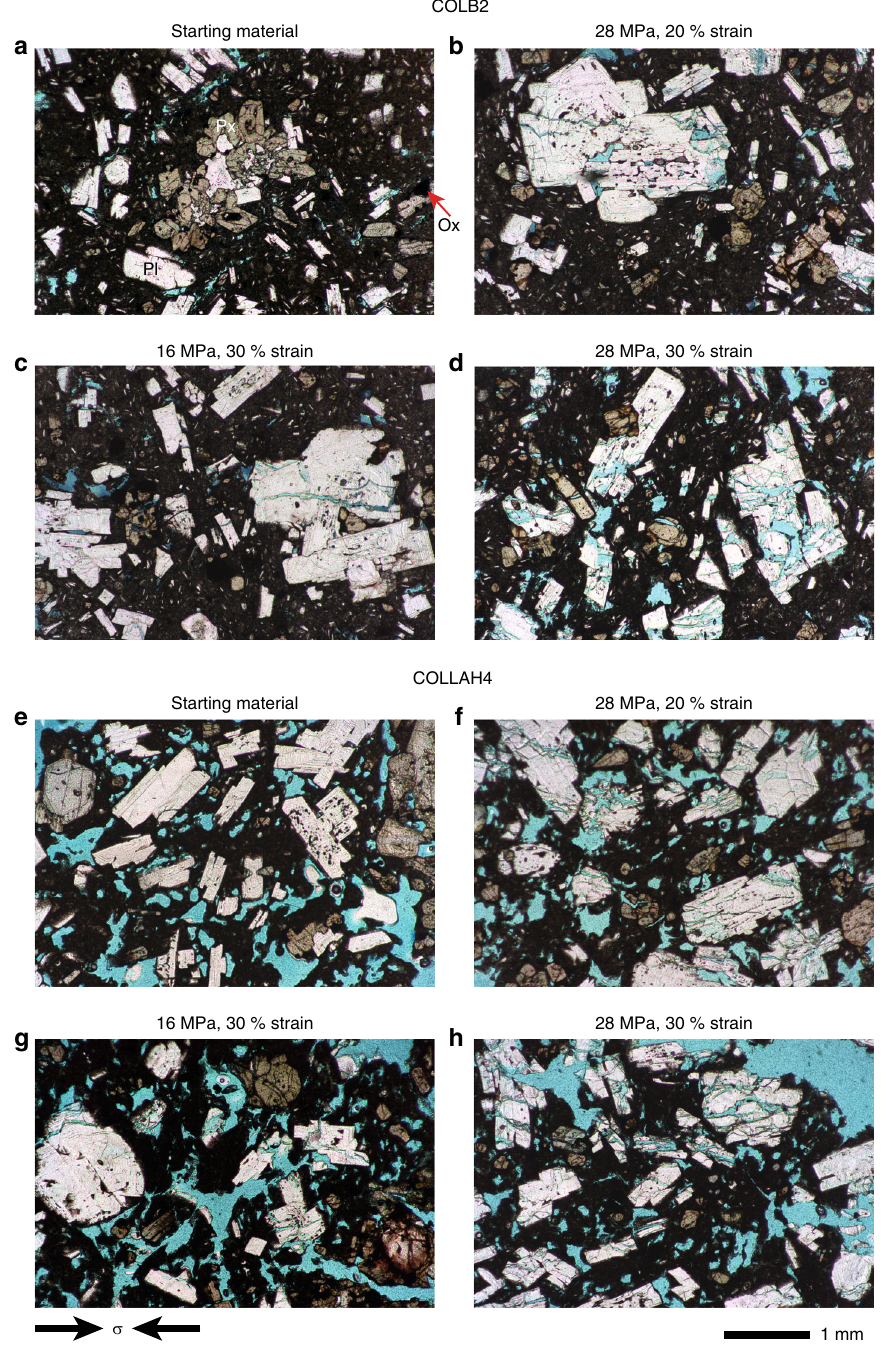
Fig. 2 Photomicrographs of the natural and experimentally deformed samples. COLB2 has relatively few pores (in blue), and those present are small and intermittently clustered in the starting material ( a ). COLLAH4 starting material has more, larger, vesicle-shaped pores ( e ). In both samples ( b – d for COLB2, f – h for COLLAH4), applying stress and strain resulted in fracturing sub-parallel to the compression direction (compression direction is horizontal in the current view). These fractures are fi rst seen in the crystals at lower stress or strain conditions, and then as imposed stress or strain is increased, the fractures coalesce through the interstitial glass, and grain crushing dominates. Scale bar is 1 mm and refers to all panels. PI plagioclase, Px pyroxene, Ox iron-titanium